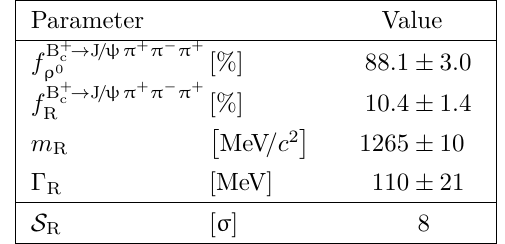
Results for parameters from the non-extended fit to the background-subtracted (cid:25) + (cid:25) − mass spectrum from the B + → J / (cid:25) + (cid:25) − (cid:25) + decays. The last row shows the statistical sig- c nificance for the R structure estimated using Wilks’ theorem